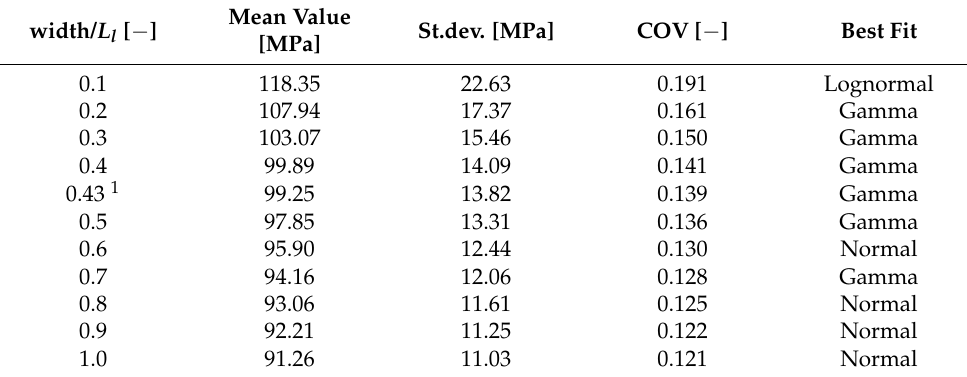
Table 5. Data for a varying ratio of the width to the loading